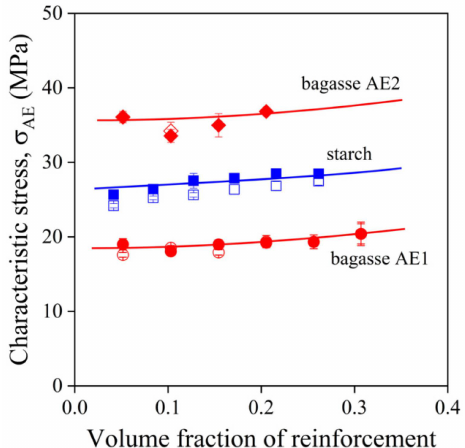
Figure 7. Composition dependence of characteristic stresses derived from acoustic emission testing. Figure 2. Composition dependence of the stiffness of PLA composites reinforced with starch or ba-